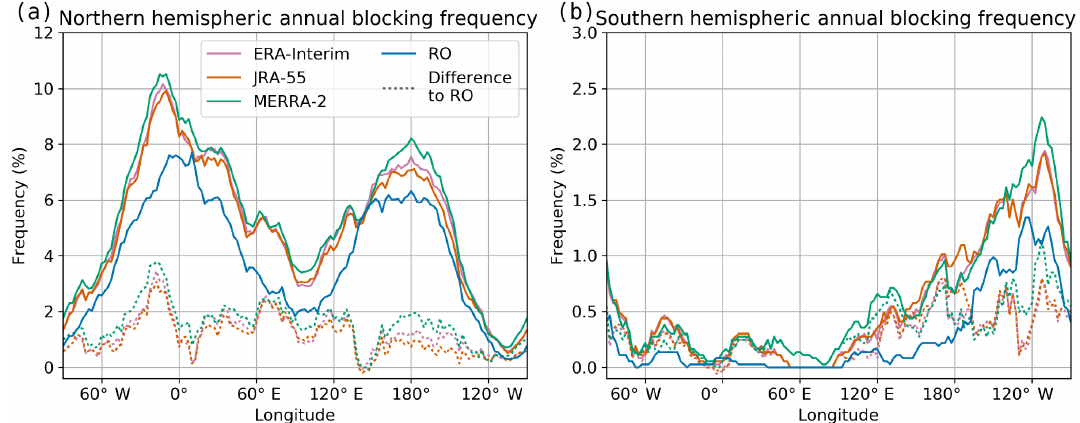
Figure 1. Annual mean blocking frequencies for the (a) Northern and (b) Southern Hemisphere in the period September 2006 to August 2016. Each coloured line represents a data set, the dashed lines show the respective differences of reanalyses to RO. Note the different y -axis